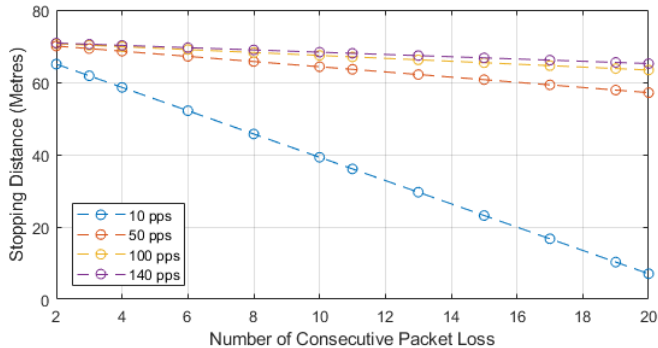
Figure 21. Joint loss—1% density losses.